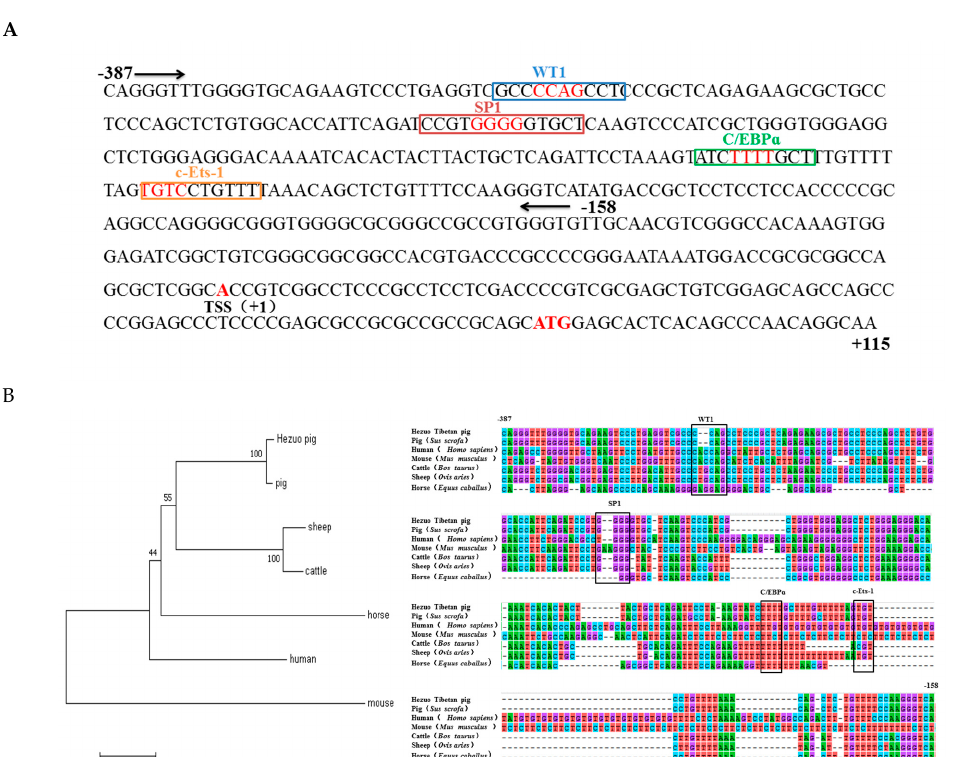
Figure 4 Figure 4. Transcription factor prediction and multi-species homology analysis in the core promoter region. ( A ) Transcription factor prediction of core promoter region. Four essential transcription factors WT1, Sp1, C / EBP α , and c-Ets-1 were predicted in − 387 / − 158, the location of the 4 bp core binding is indicated in red. ( B ) Sequence alignment and phylogenetic construction of core promoter regions in six species. The box represents the 4 bp core binding